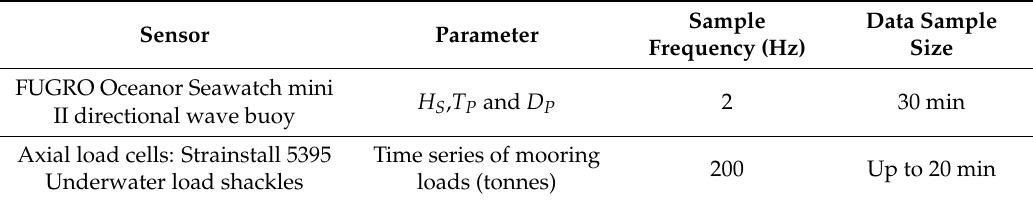
Table 3. Summary of the instrumentation at the Bolt-2 LifeSaver